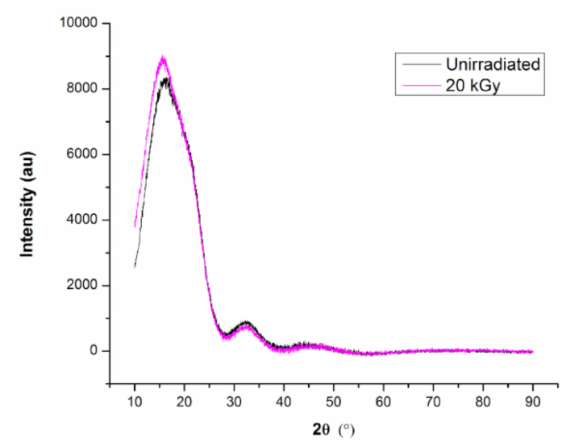
Figure 8. Diffractograms for unirradiated and 20 kGy irradiated PLA.